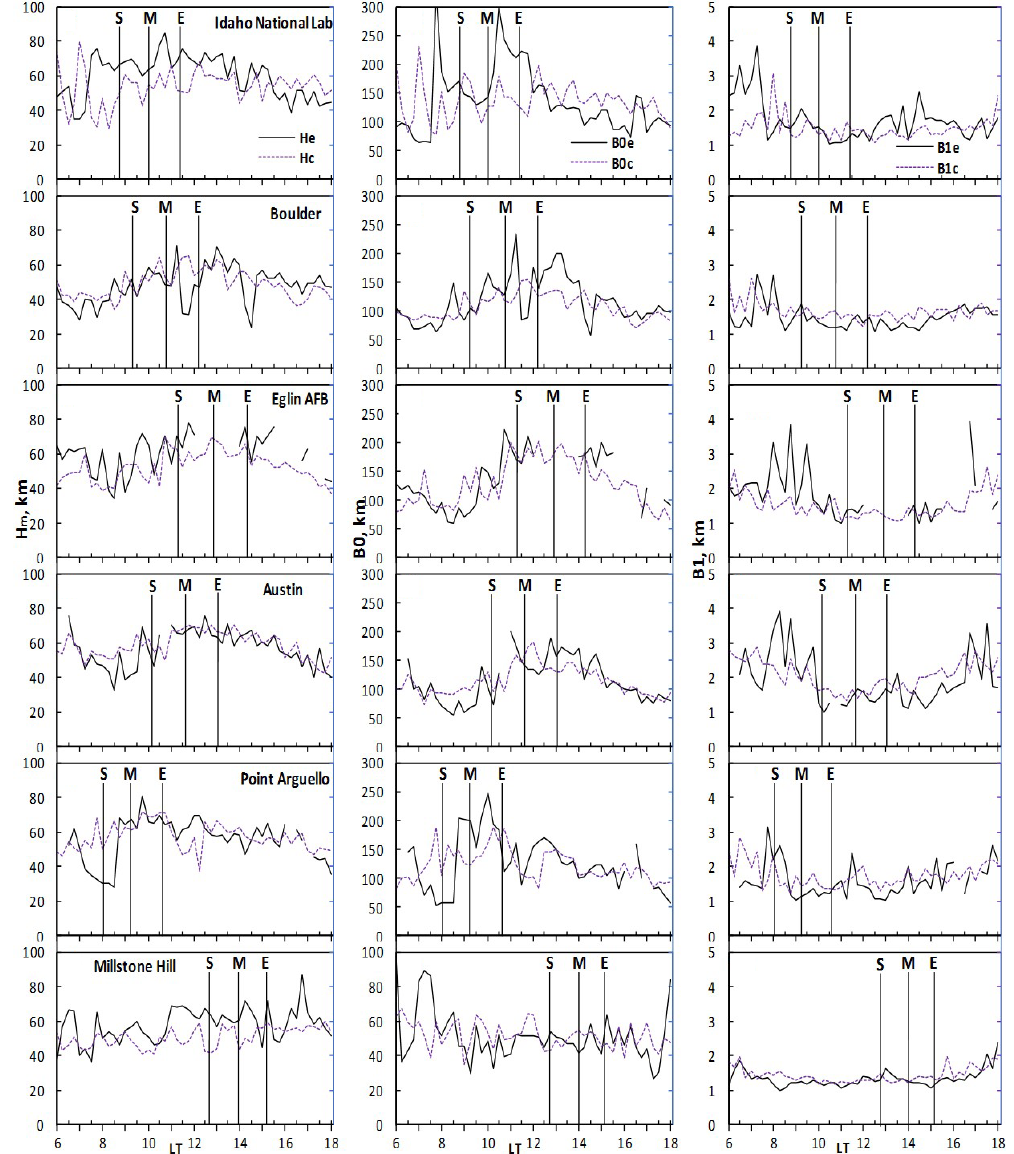
Figure 3. The local time variation in the ionospheric scale height and the bottomside ( B0 and B1 ). The other features are the same as in Fig. 2.